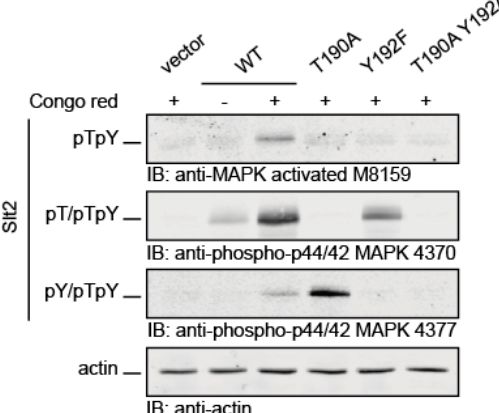
Figure 1. Detection of mono and dually phosphorylated Slt2 species with commercial antibodies. slt2 Δ (Y00993 strain) cells containing plasmid pRS316 expressing Slt2 (WT), Slt2 T190A , Slt2 Y192F , or Slt2 T190A Y192A were grown to the mid-exponential phase in yeast extract–bacto-peptone–dextrose (YPD) and then stimulated with 30 µg/mL of Congo Red for 2 h (+). Cell extracts were resolved by SDS–PAGE, and analyzed by immunoblotting with the M8159 antibody (upper panel), which detects dually phosphorylated Mitogen-Activated Protein Kinase (MAPK) (pTpY); the 4370 antibody (middle panel), which detects T190 and dually phosphorylated MAPK (pT/pTpY); and the 4377 antibody (lower panel), which detects Y192 and dually phosphorylated MAPK (pY/pTpY). An anti-actin antibody was used for the loading control. A representative assay from three different experiments with distinct transformants is shown.